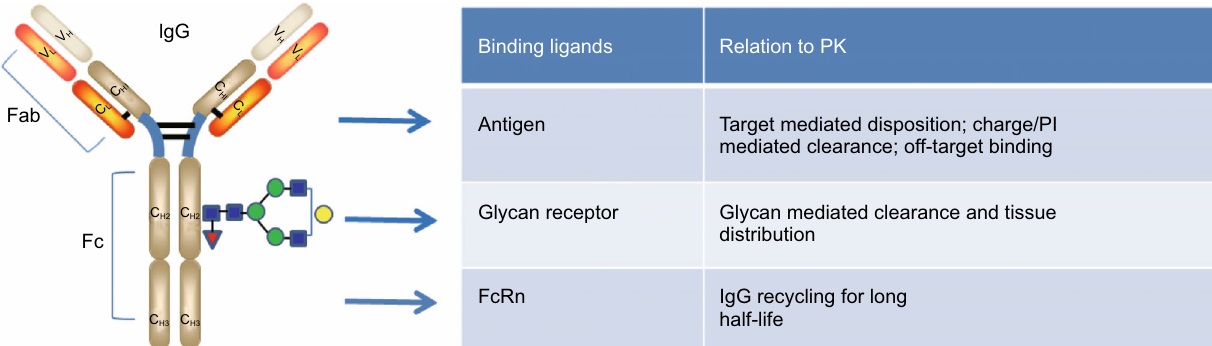
Figure 2. FcRn mediated IgG recycling pathway and antibody mediated antigen removal via pH